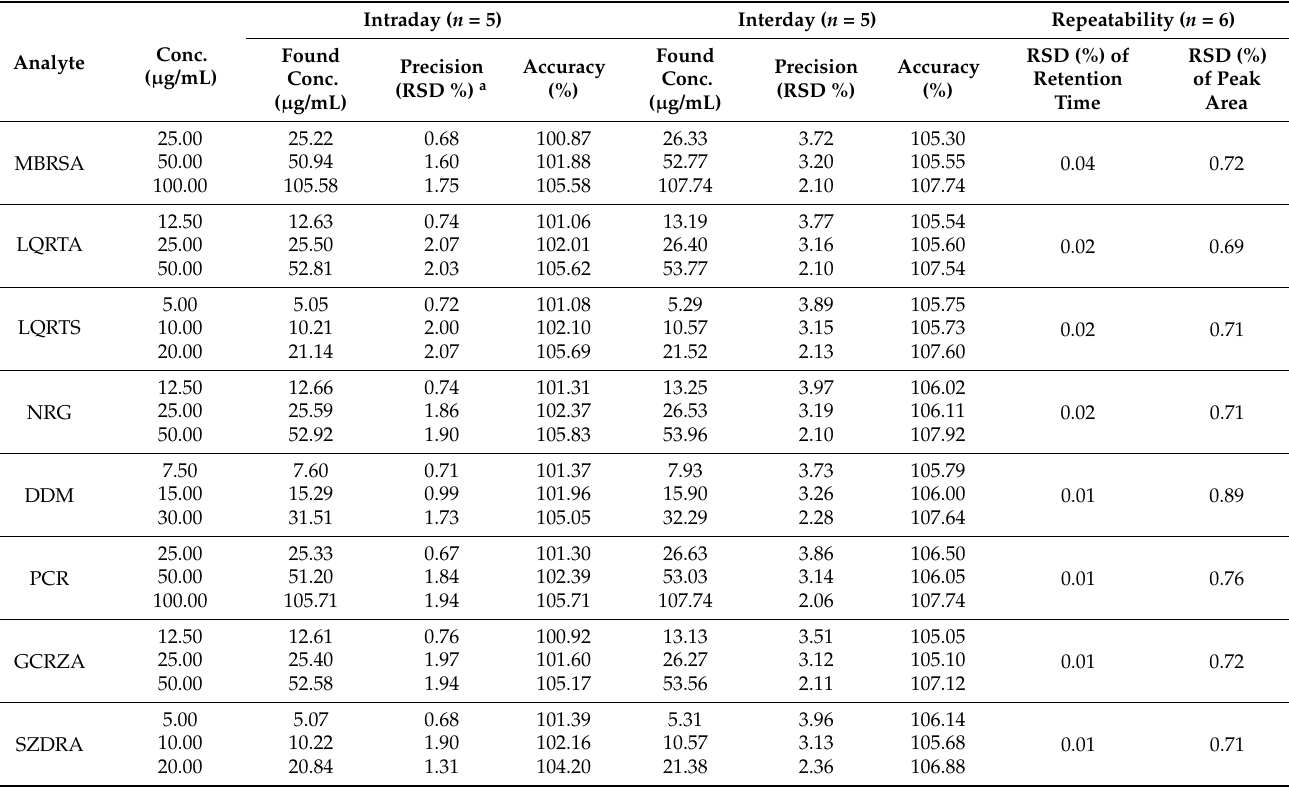
Table 3. Precision of the assay of the eight authentic standards.